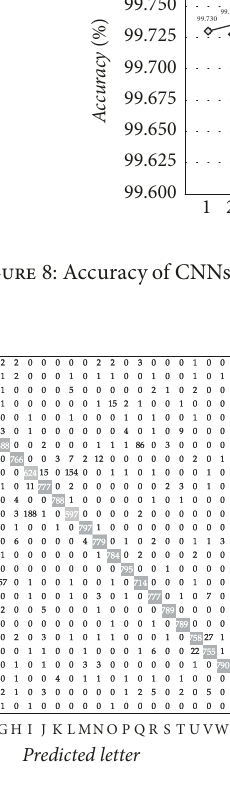
Figure 9: Confusion matrix of the best committee found for EMNIST Letters.